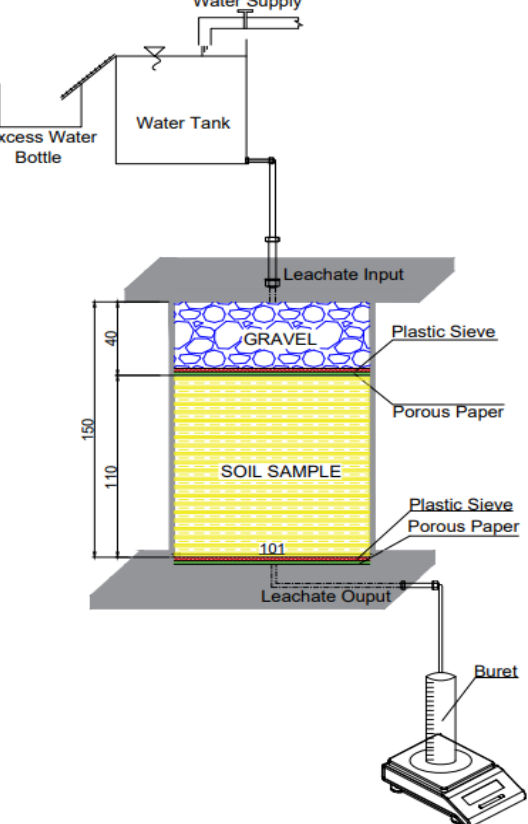
Figure 1. Schematic view of the experimental setup [42].